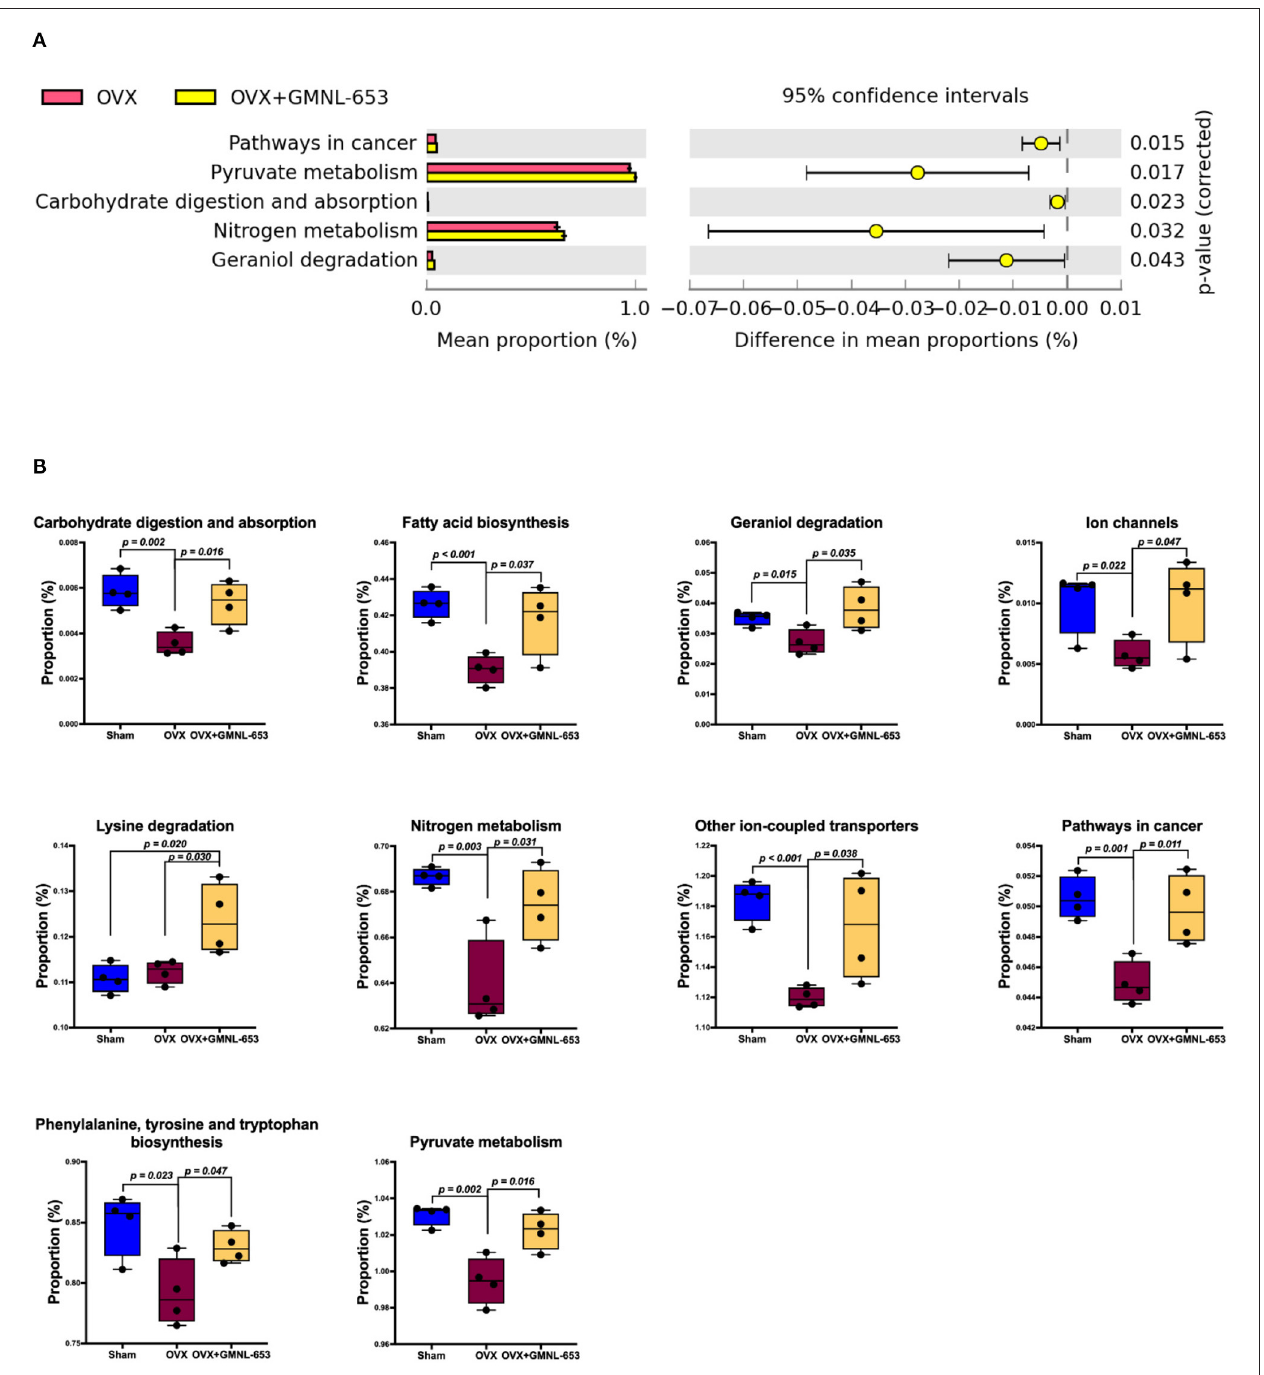
FIGURE 6 | Predicted function of the involved gut microbial using the phylogenetic investigation of communities by the reconstruction of unobserved states 2 (PICRUSt2) in the sham and OVX mice treated with either the vehicle (H 2 O) or heat-killed GMNL-653. (A) Pairwise comparison showed that five function pathways were significantly increased in mice treated with GMNL-653 vs. OVX mice. Among them, 4 of 5 function pathways were included in the metabolism of pyruvate, carbohydrate, nitrogen, and geraniol. (B) There were nine function pathways overlapped between OVX vs. GMNL-653 and Sham vs. OVX and were significantly decreased in the OVX mice as compared to the Sham group, but further increased upon GMNL-653 treatment. It is noted that only Lysine degradation pathway was overlapping between OVX vs. GMNL-653 and Sham vs. GMNL-653 and was significantly increased in the OVX mice as compared to the Sham group, but was further increased when treated with GMNL-653. p < 0.05 is considered as statistically